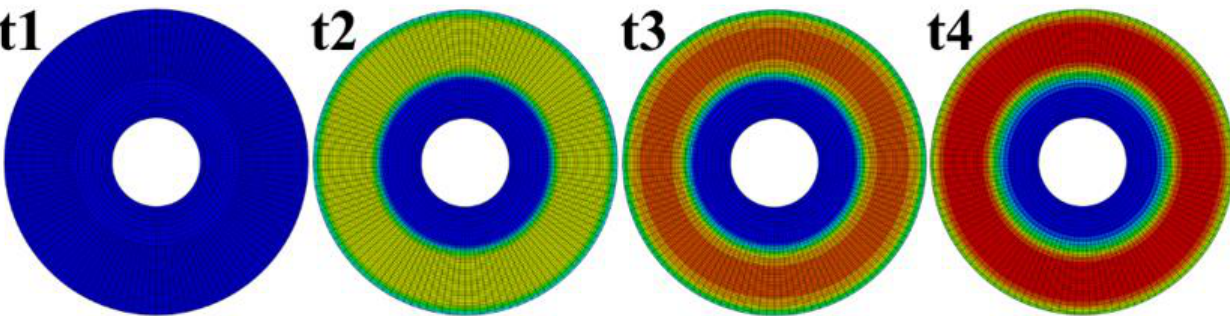
Figure 5. Temperature distribution with uniform loading at different moments (highest temperature 454 °C occurs at t4 = 35 s).